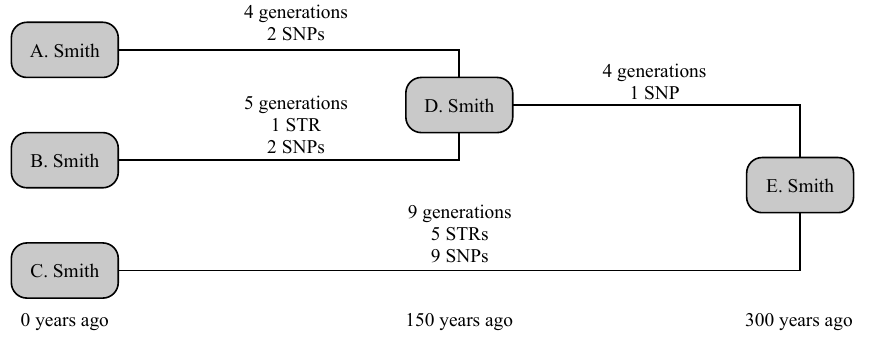
Figure 1. A schematic representation of the example given in Section